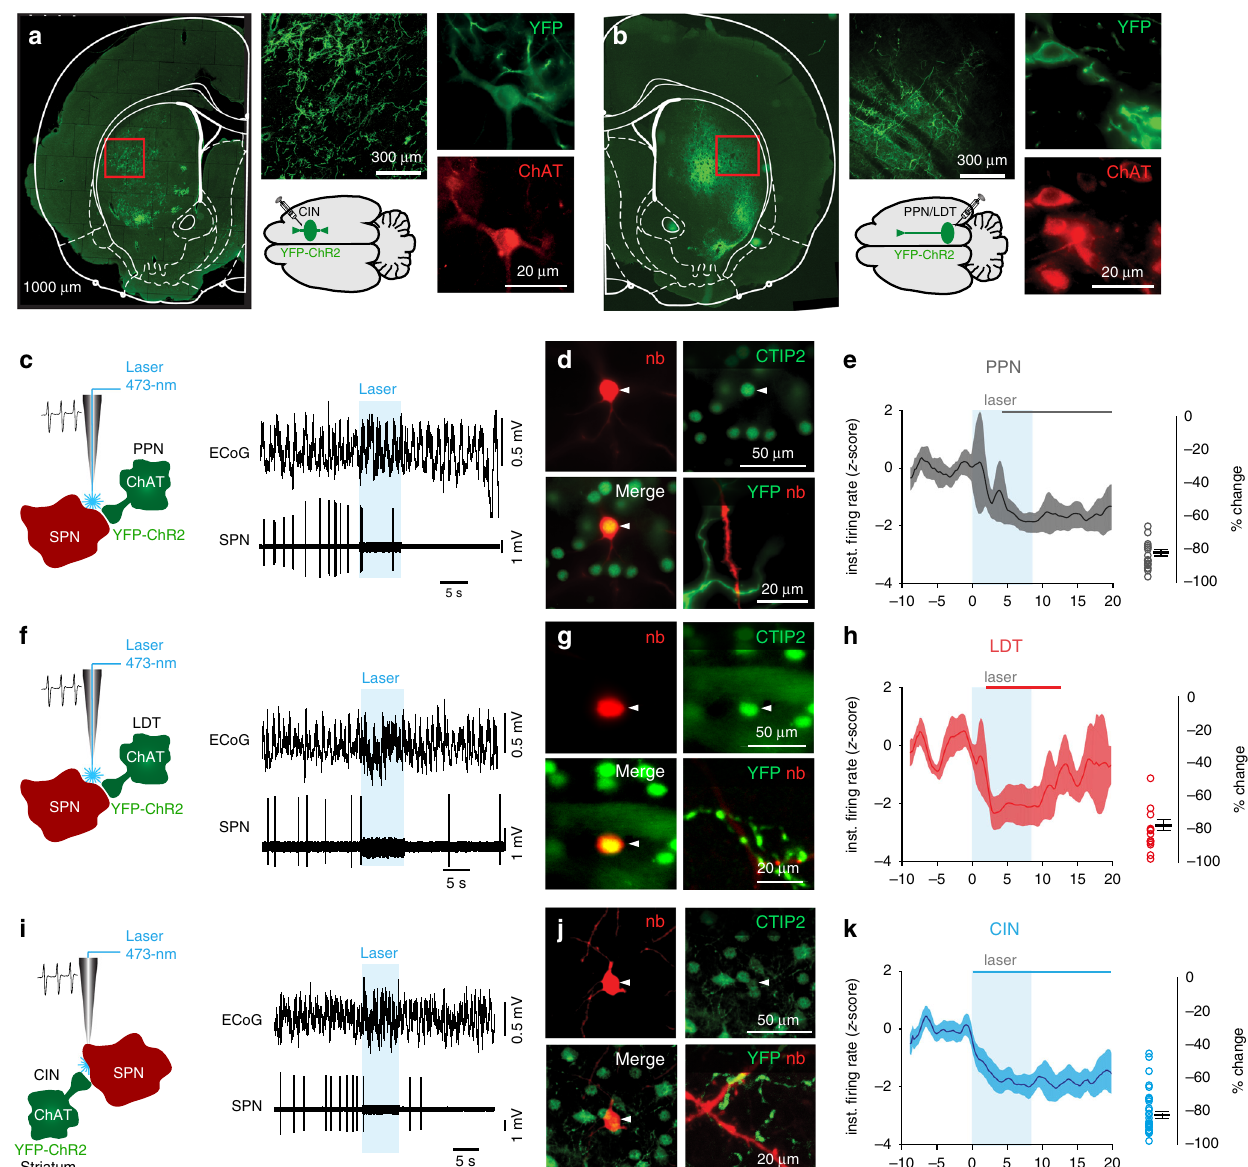
Fig. 2 Cholinergic modulation of striatal spiny projection neurons (SPN). a Transduction of striatal cholinergic interneurons (CINs) in ChAT::Cre + rats with channelrhodopsin-2 (ChR2, AAV2-DIO-EF1a-ChR2-YFP) shows dense axonal labeling in the striatum and YFP-positive somata that were immunopositive for ChAT. b Transduction of PPN and LDT cholinergic neurons in ChAT::Cre + rats with ChR2 shows patches of dense axonal innervation in the striatum and YFP + /ChAT + somata in the PPN or LDT. c Individual SPN neurons activity was recorded in vivo with a glass pipette during optogenetic activation (8s, 10Hz, 50-ms pulses) of PPN cholinergic axons. SPNs were subsequently labeled with neurobiotin (nb; n = 29 neurons from n = 12 rats). ECoG recording shows no associated change in brain state during the stimulation. d Only neurobiotin-labeled SPNs immunopositive for CTIP2 (COUP TF1-interacting protein-2, immunohistochemical marker for SPNs) and surrounded by YFP-positive axons were used for further analyses. e The normalized instantaneous fi ring rate of all SPNs that responded to laser stimulation of PPN cholinergic axons shows a slow inhibition during, and after, blue-light stimulation (color line in the top represents the time points during which the responses were signi fi cantly different from the baseline; cluster-based permutation test, P <0.05). f – h Same experimental design to assess modulation of striatal SPNs by LDT cholinergic axons ( n = 19 neurons from n = 15 rats). LDT cholinergic axon stimulation induced a reduction in the fi ring rate of SPNs, similar to PPN cholinergic axon stimulation. i – k Same experimental design to assess modulation of striatal SPNs by cholinergic axons arising from local CINs in the dorsal striatum ( n = 43 neurons from n = 17 rats). CINs axon stimulation induced a reduction in the fi ring rate of SPNs, similar to the responses of the midbrain. Following cholinergic axon stimulation from each of the three origins, SPNs showed a similar reduction in the fi ring rate (% change in fi ring rates: PPN, − 79.58±2.56, n = 29; LDT, − 78.39±1.92, n = 19; CINs, − 79.24±2.43, n = 43; one-way ANOVA F (2,64) = 0.042, P = 0.959). Individual data points and mean±SEM are shown. * P <0.05. All experiments have been replicated at least three increases their fi ring discharge during the presentation of blue 2.86 ± 0.37 Hz, n = 53; parvalbumin [PV]-expressing inter- light (Supplementary Fig. 2A – D). The same light stimulation neurons: 7.24 ± 1.33 Hz, n = 28), in agreement with previous affected neither the fi ring rate of neurons expressing the reporter studies (only neurons recorded during slow-wave activity were alone (Supplementary Fig. 2E – H) nor the activity of their included 23 ). We con fi rmed that the expression of ChR2 in CINs